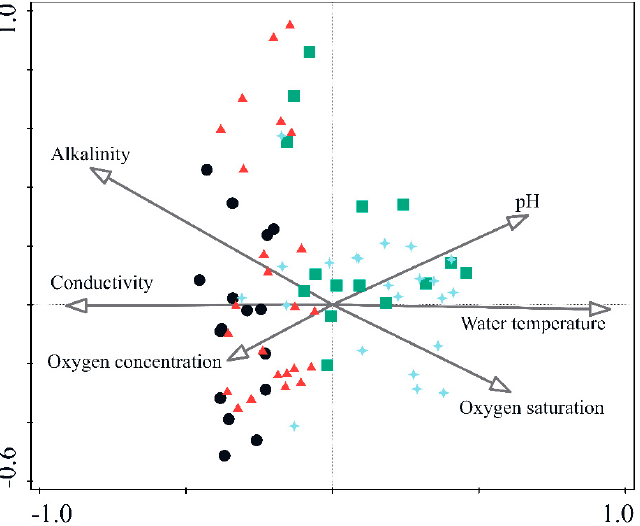
Figure 2. Canonical correspondence analysis (CCA) ordination of caddisfly communities (samples) and physico-chemical water parameters. Physico-chemical water parameters are portrayed with arrows; arrow length indicates the relative importance of the explanatory variables (physico-chemical parameters), and direction—relative to each other and to the sites—indicates positive or negative correlations. Samples (caddisfly communities) from different habitat types are marked as follows: Springs— black circle ; Upper stream reaches— red triangle ; Tufa barriers— blue cross ; Lower stream reaches— green rectangle .